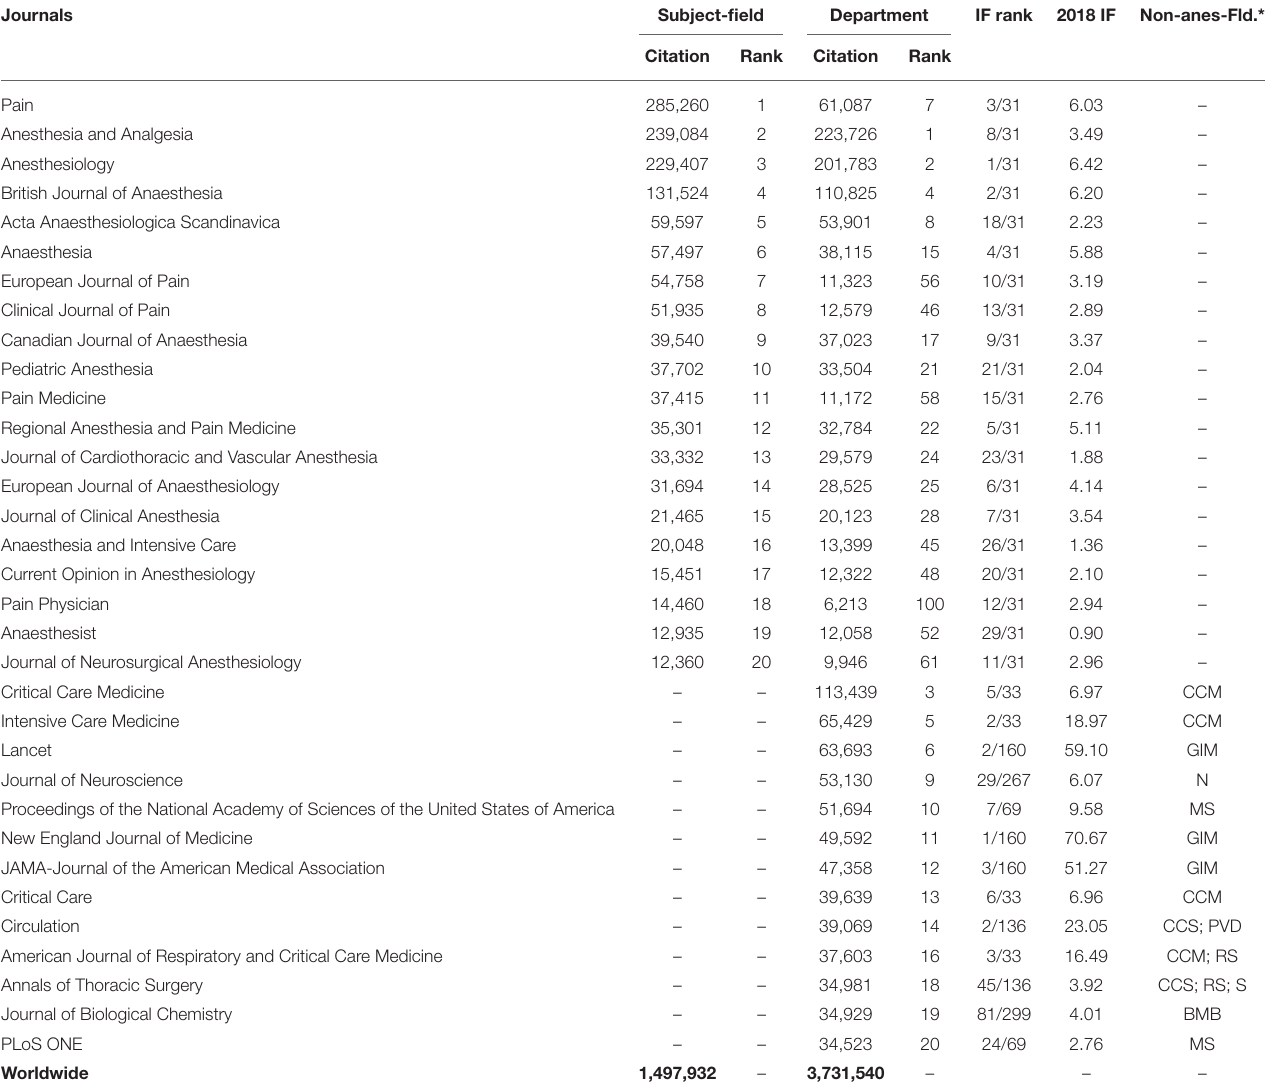
TABLE 2 | The top 20 journals by number of citations in the subject-field dataset and department dataset in